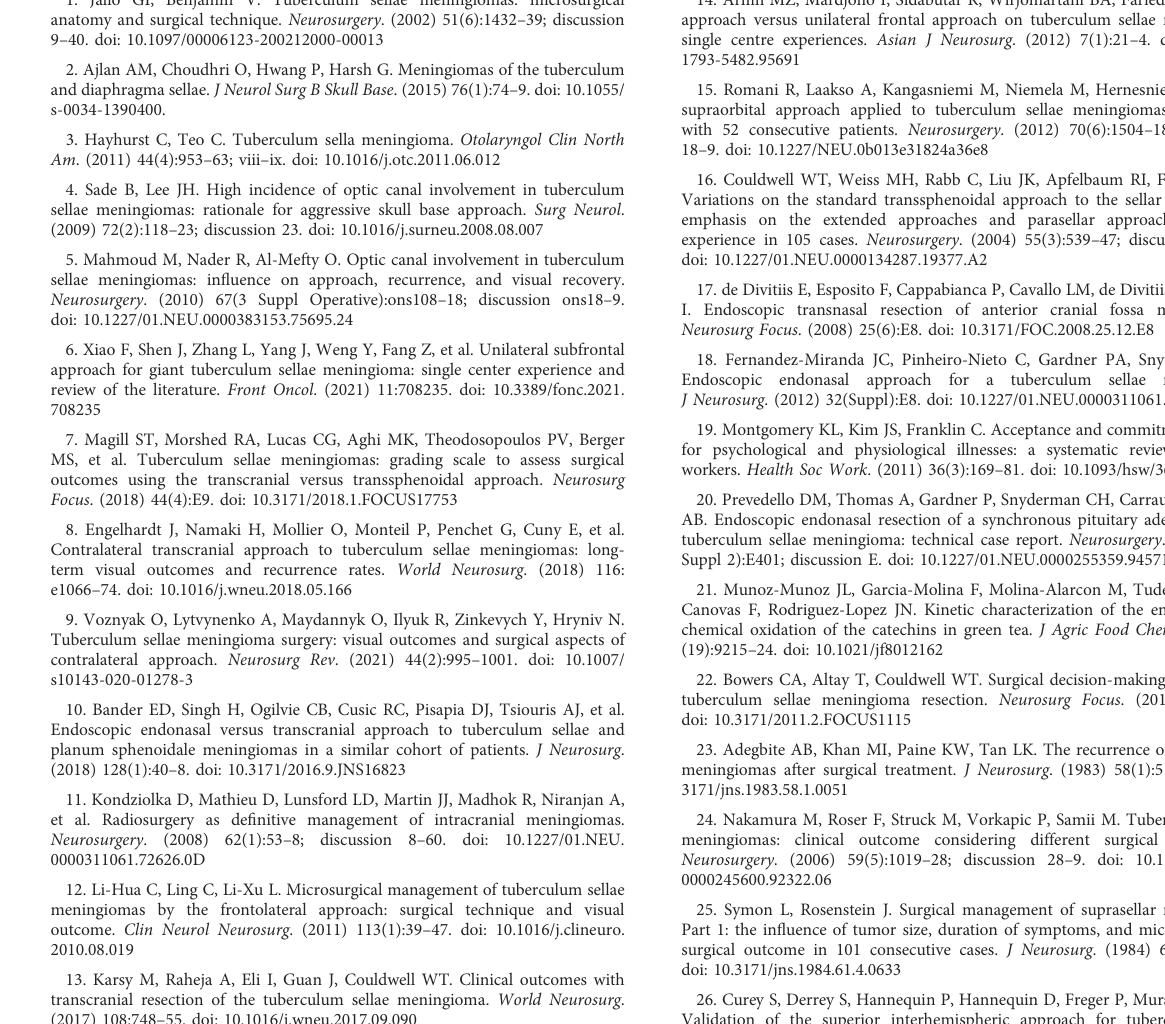
SUPPLEMENTARY FIGURE 1 Evaluation the angle between the panum sphenoidal and the depth of the sella turcica in a TSM patient. Red line: angle between the panum sphenoidal and the sella turcica; blue dotted line: the line between the planum sphenoidal clivus; blue line: the depth of the sella